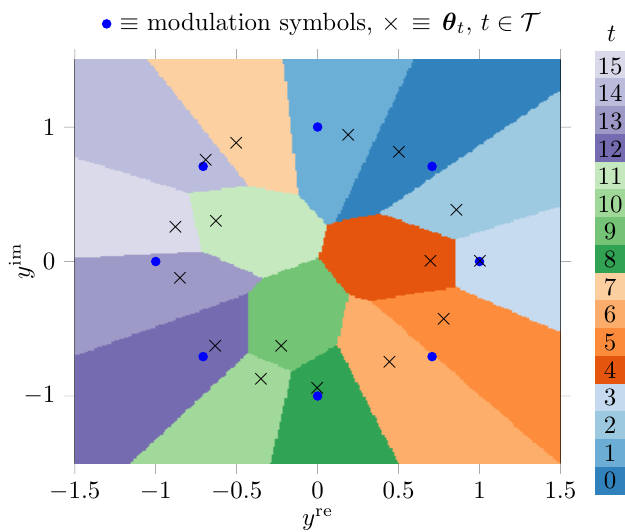
from Section 3.2.2.